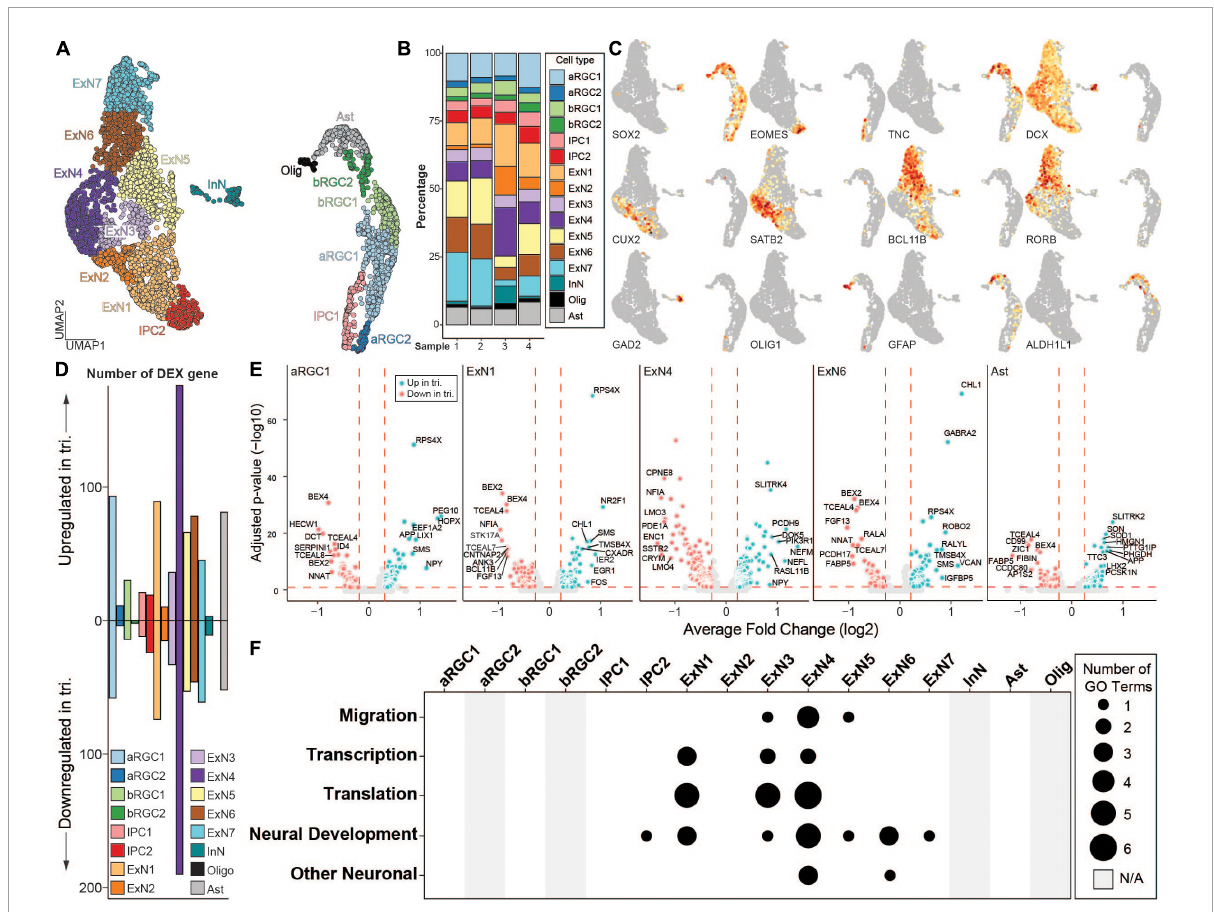
FIGURE3 scRNA-seq analysis of isogenic euploid and trisomic cortical spheroids (CS) at day 130. (A) UMAP representation of scRNA-seq data collected from two euploid and two trisomic CS samples. Colors represent identified cell types. ARGC, apical radial glial cell; bRGC, basal radial glial cell; IPC, intermedial progenitor cell; ExN, excitatory neuron; InN, inhibitory neuron; Ast, astrocyte; Olig, oligodendrocyte. (B) Bar graph showing the percentage of each identified cell type in each sample. Colors represent same cell types as in panel (A) . Sample 1 and 2 are euploid, whereas 3 and 4 are trisomic. (C) UMAP as in panel (A) showing gene expression levels of canonical markers. Colors represent normalized gene expression level (norm. exp.). (D) Bar graph showing the number of up- or down-regulated differentially expressed (DEX) genes in trisomic vs. euploid single cells by cell type. Colors represent same cell types as in panel (A) . (E) Volcano plots showing DEX genes in cell types. Five cell types with the highest numbers of DEX genes are shown. Colors represent genotype (euploid, red; trisomic, blue). Vertical red dashed lines represent average log2 fold change of –0.25 or 0.25. Horizontal red dashed lines represent adjusted p -value of 0.1. Eu, euploid; tri, trisomy. (F) Dot plot showing the number of enriched gene ontology (GO) terms in each cell type. Enriched GO terms are grouped into five categories of “Migration”, “Transcription”, “Translation”, “Neural Development” and “Other Neuronal.” Size of the dot represents number of enriched GO terms. Gray bar represents cell types where no DEX genes were identified and thus not applicable (N/A) to the GO